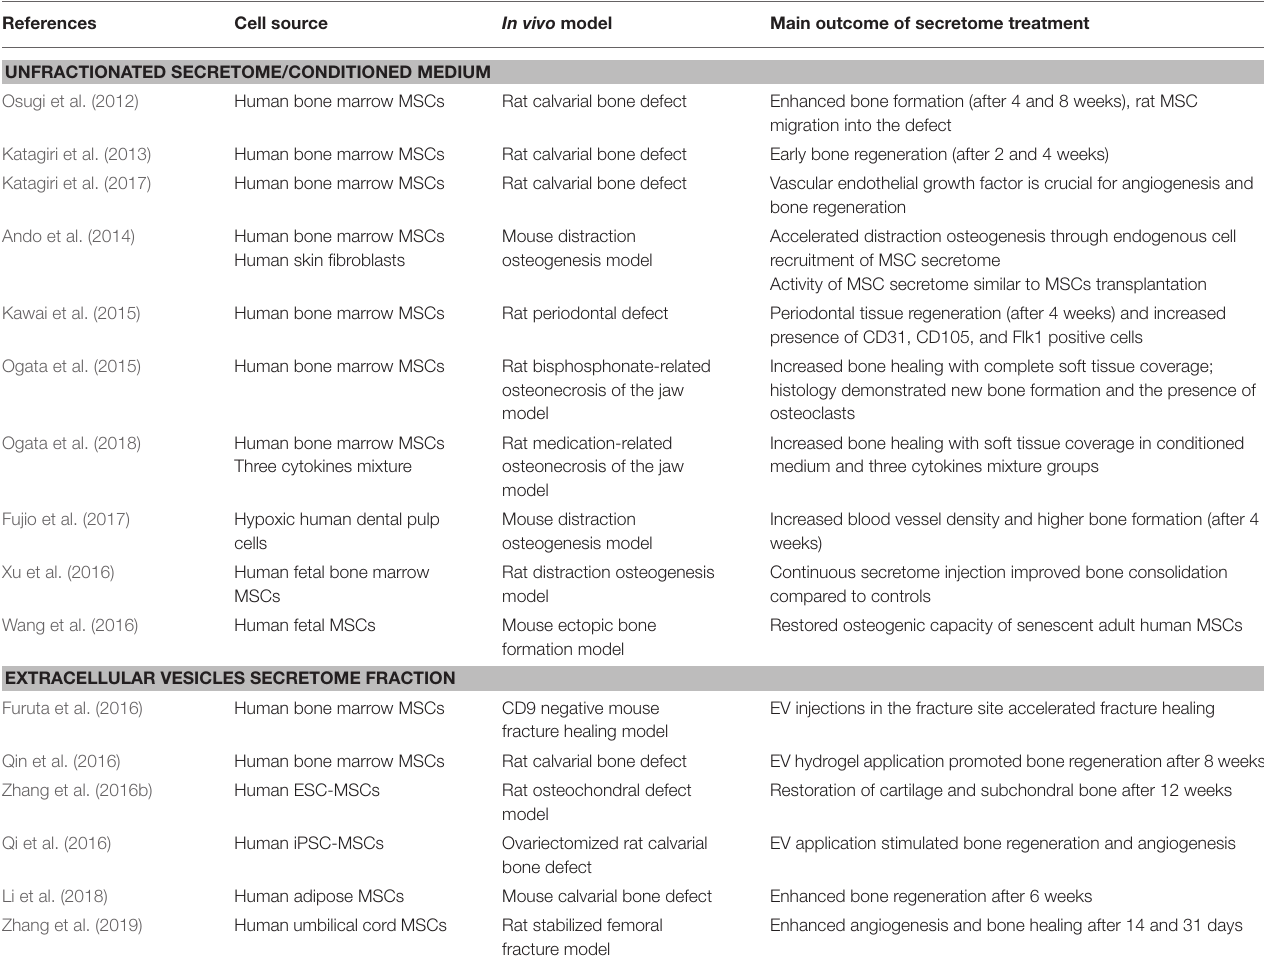
TABLE 2 | Preclinical studies reporting the use of MSC-secretome and MSC-EVs for bone